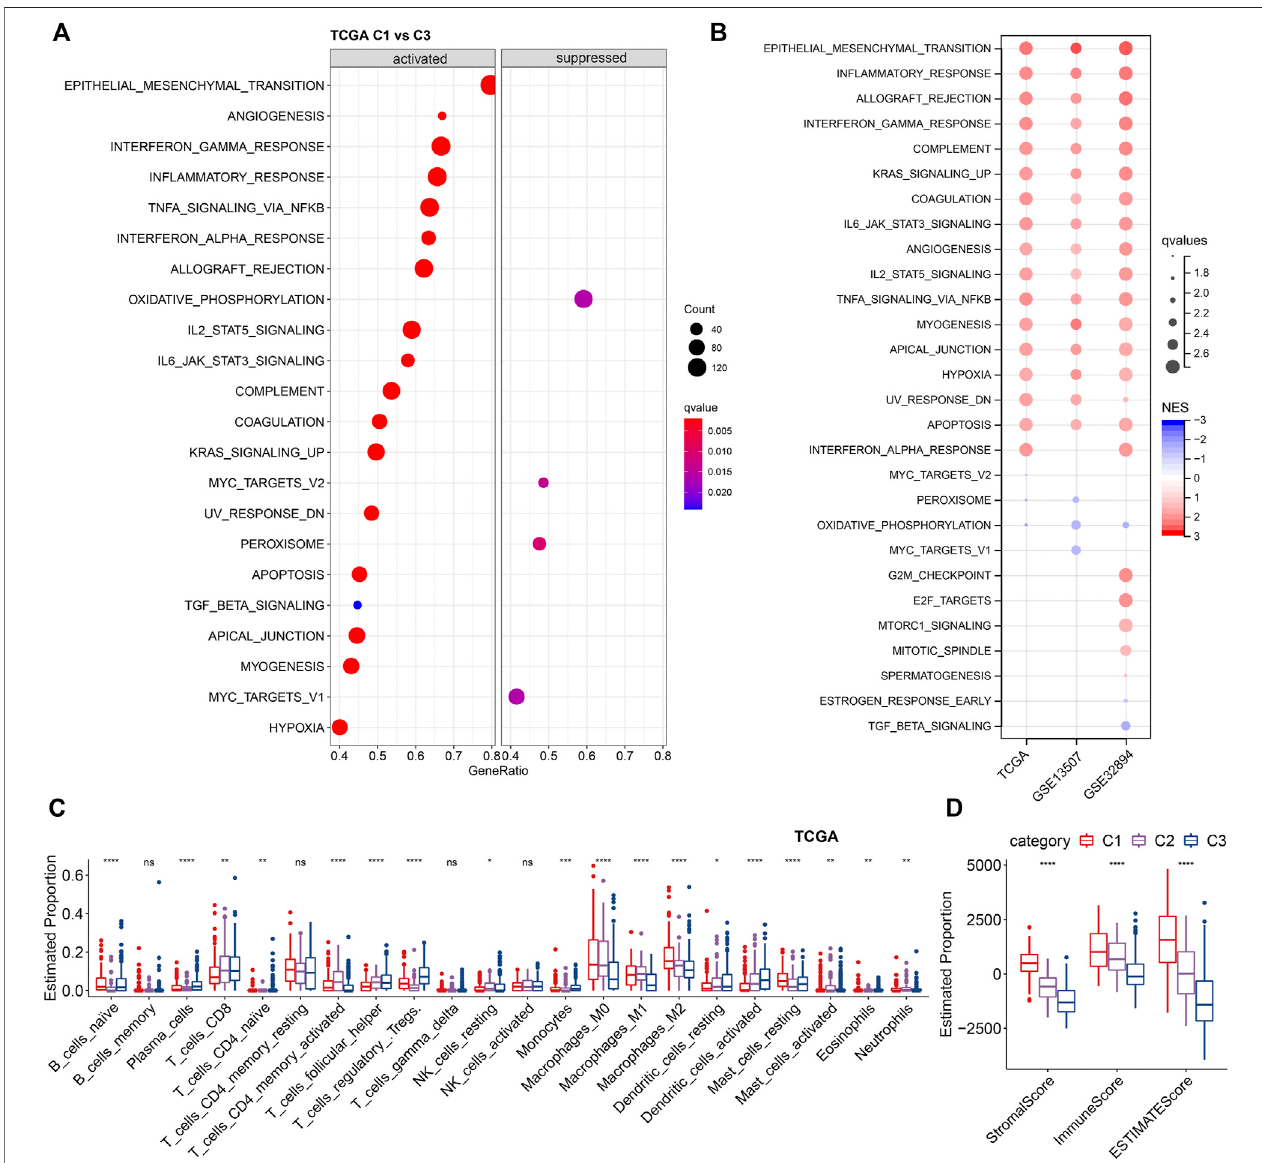
FIGURE 5 | Enrichment analysis of LR-based clusters (A) . Dot plot of top 20 hallmarks of GSEA results between C1 and C3 in TCGA cohort. (B) . Dot plot of signi fi cant hallmarks of GSEA results in TCGA, GSE135607, and GSE32894 cohorts. Blue color indicates downregulated hallmarks; red color indicates upregulated hallmarks. (C) . The distribution of 22 immune cell types among LR-based clusters by CIBERSORT in TCGA cohort. ns, p > 0.05; * p < 0.05; ** p < 0.01; *** p < 0.001. Kruskal-Wallistest. (D) .ThedistributionofstromalandimmunescoresamongLR-basedclustersbyESTIMATEinTCGAcohort.ns, p > 0.05;* p < 0.05;** p < 0.01; *** p < 0.001. Kruskal-Wallis